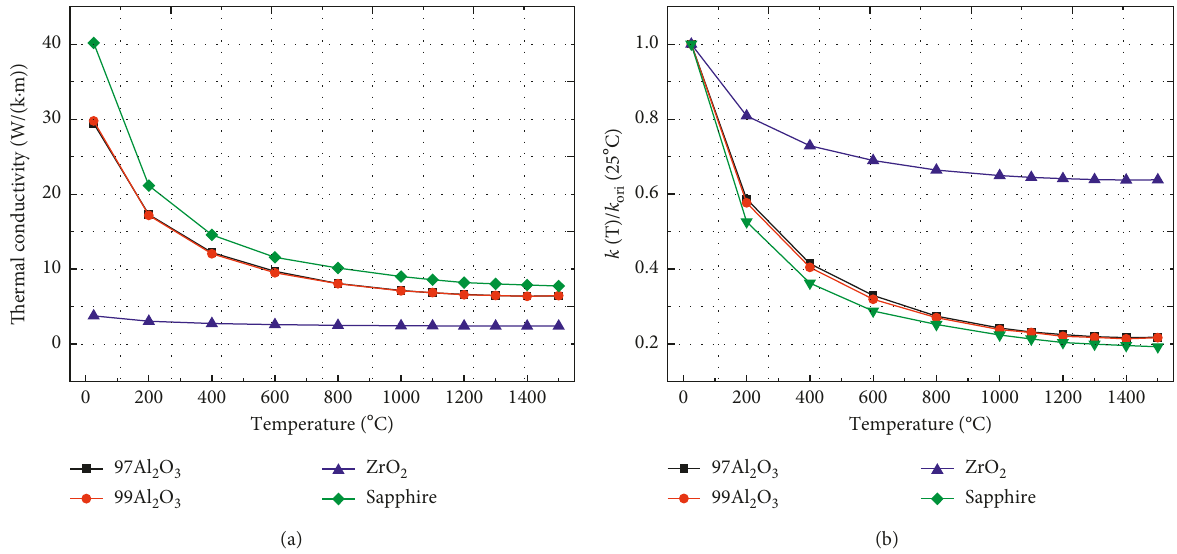
Figure 5: (a) Thermal conductivity change with the temperature. (b) The percentage of the thermal conductivity change with